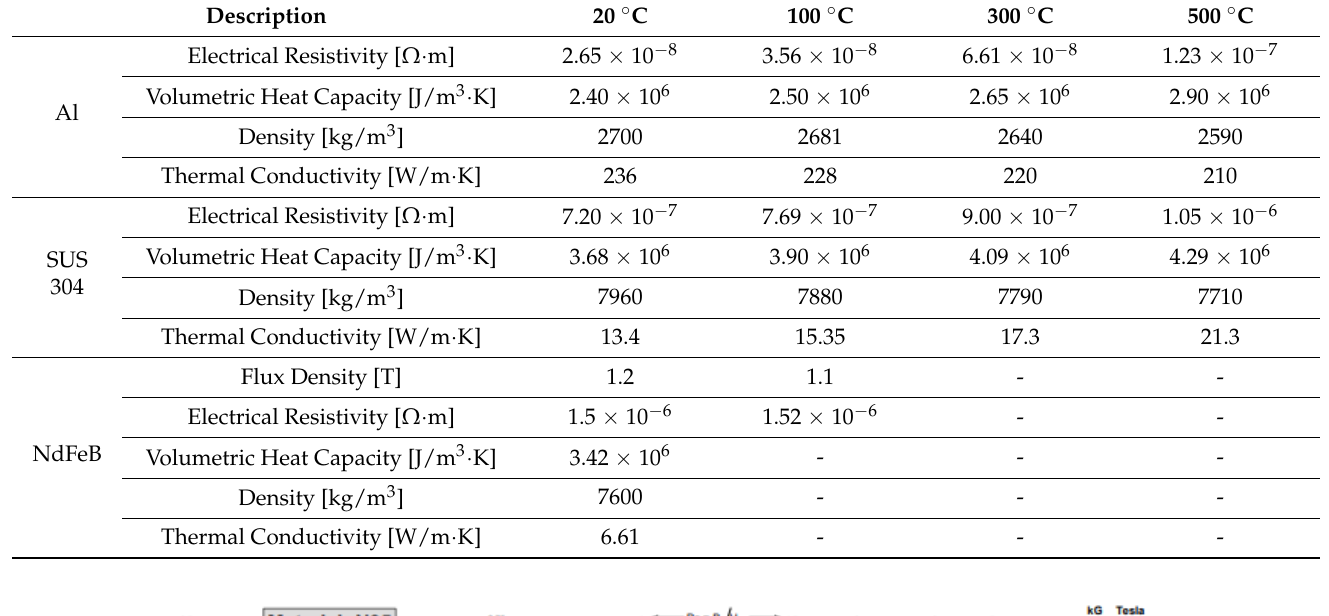
Table 1. Physical properties of billet heating design parts [40,41].